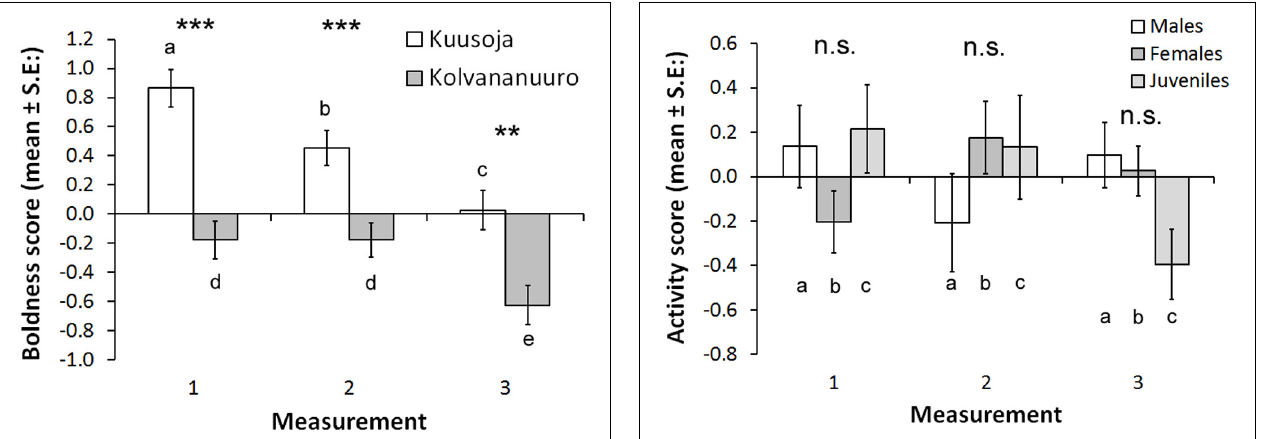
FIGURE 3 | Estimated marginal means for boldness scores in the three behavioral trials in the two study populations (Kuusoja River and Kolvananuuro Brook). Paired differences are indicated with asterisks ( ∗∗∗ P < 0 . 001; ∗∗ P < 0 . 01), and among measurement differences within populations with different letters (alpha = 0.05).